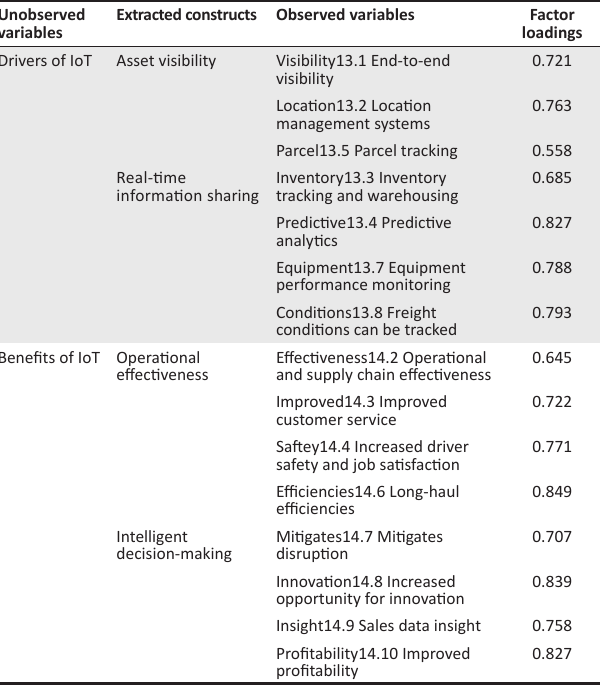
TABLE 2: Rotated component matrix of drivers and benefits of internet of things. Unobserved variables